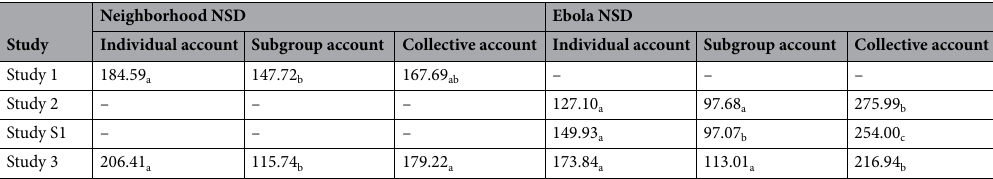
Table 3. Mean allocations to individual, subgroup, and collective account across different studies. Cell means within a row not sharing a common subscript differ significantly ( p < 0.05) in Wilcoxon Signed Ranks tests. Post hoc tests within rows were preceded by Friedman tests of the effect of account types.